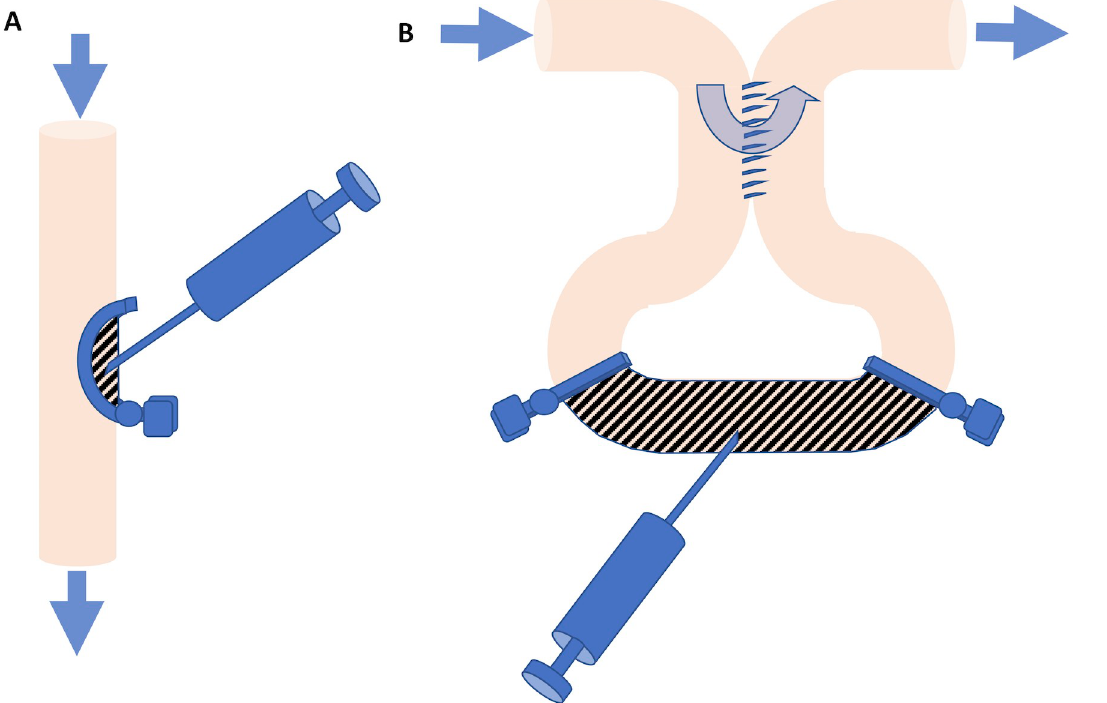
Fig 1. (A) Cells were implanted into a jejunal segment (hatched area) that was in continuity of the small intestine by isolating a mucosal pocket using a semicircular clamp. (B) Alternatively, cells were injected into a bypassed jejunal segment that did not receive the regular stream of bowel content (hatched area). The arrows show direction of the flow of the ingesta.